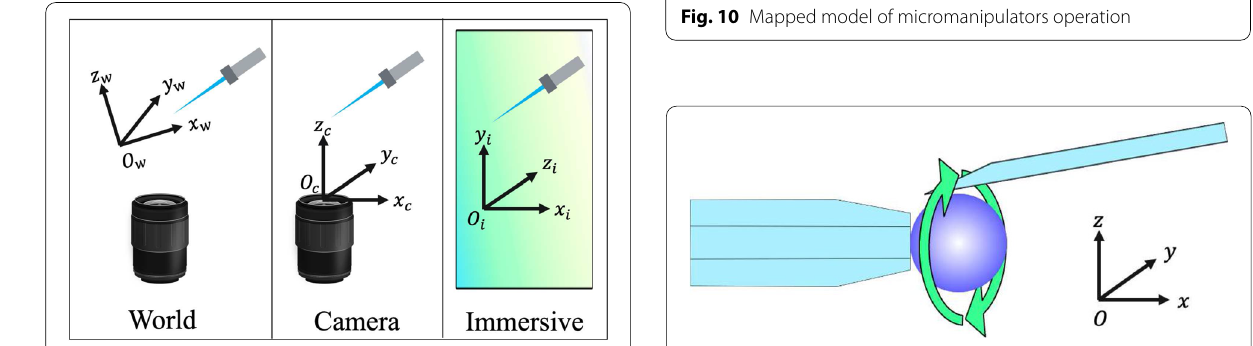
Fig. 11 Experimental task to verify the operation